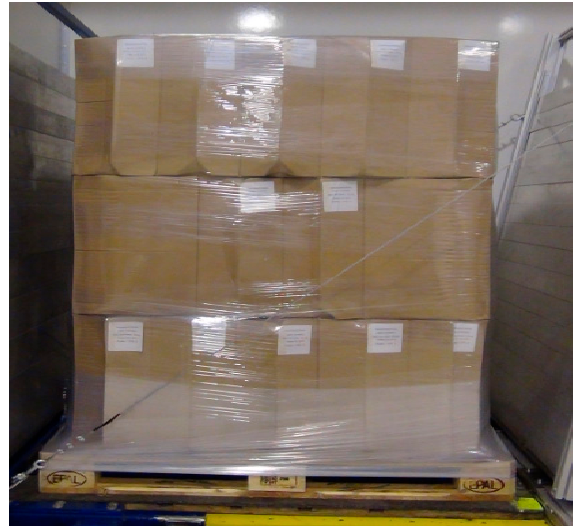
Figure 5. Cargo to be tested—before stability tests are carried out.